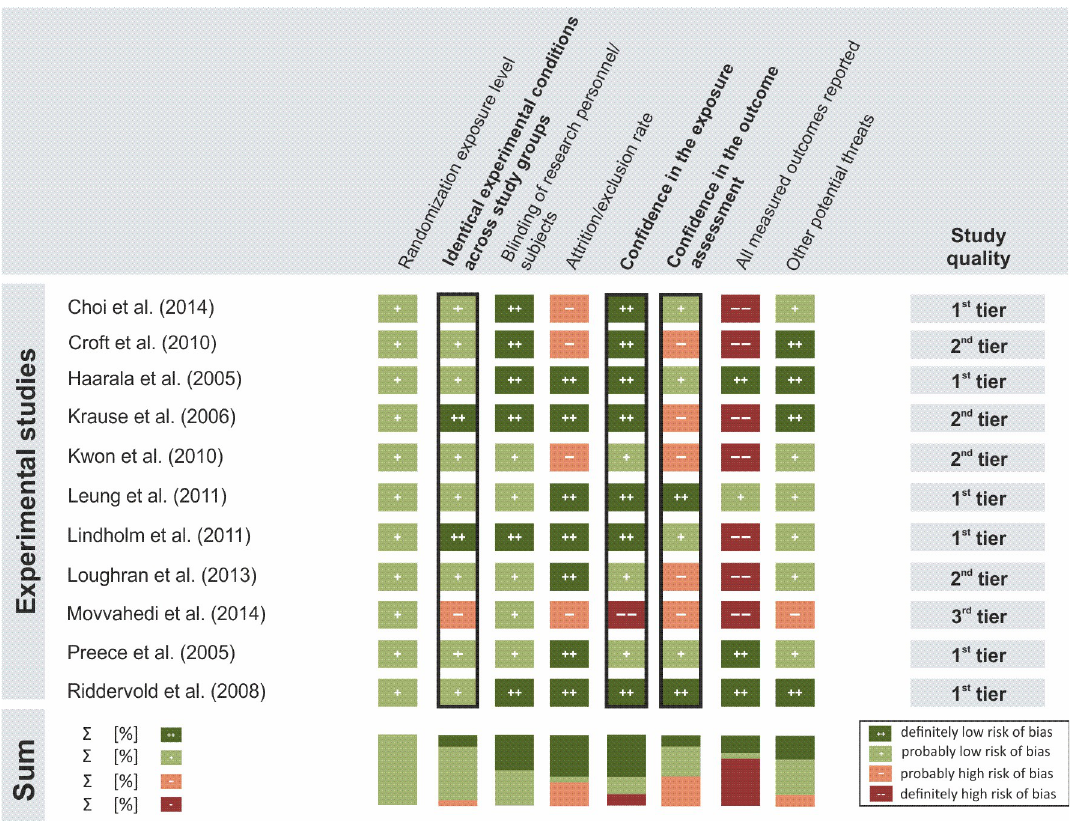
Fig 2. Risk-of-bias ratings for epidemiological studies (n = 42). Criteria ratings served as the basis for the assignment of individual studies to one out of 3 study quality categories (1 st tier, 2 nd tier, 3 rd tier; see S1 Fig). Black frames indicate key risk-of-bias criteria.